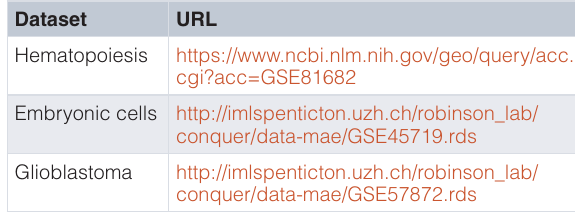
Table 1. Datasets and availability.